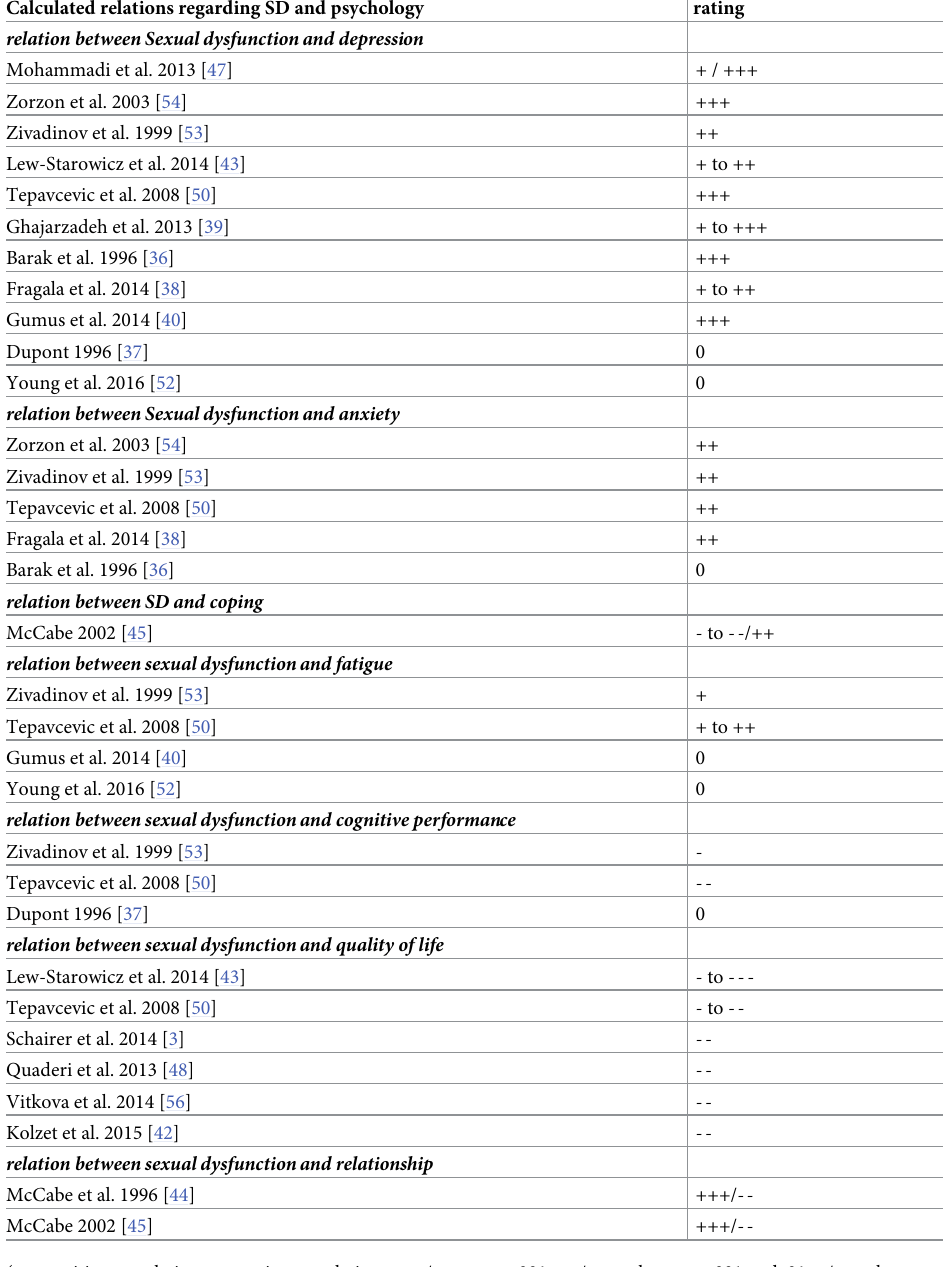
Table 3. Relations between SD and psychological and neuropsychological measures. Calculated relations regarding SD and psychology rating relation betweenSexualdysfunctionand depression Mohammadi et al. 2013